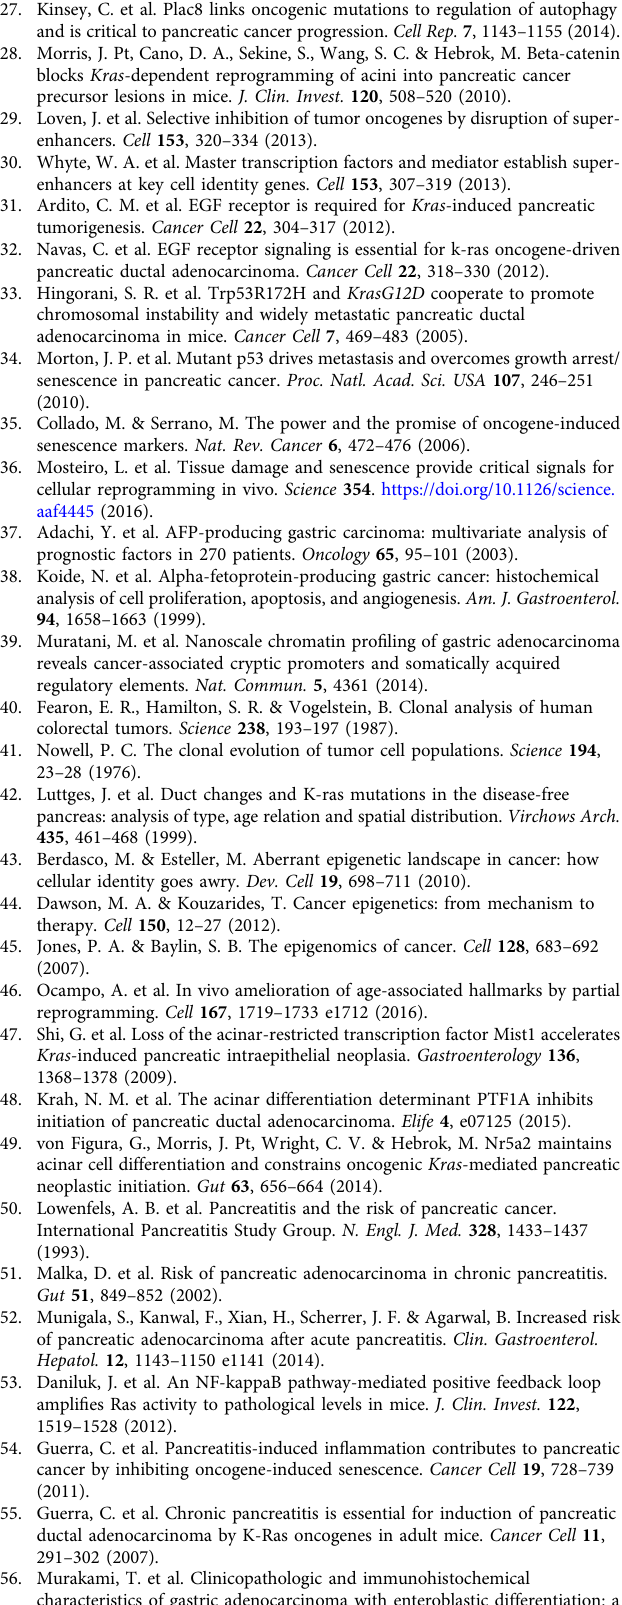
Patients-derived paraf fi n-embedded tissue samples . Human patients-derived paraf fi n-embedded tissue samples were used in compliance with ethical regulations in Kyoto University Hospital. Statistical analysis of survival . Kaplan – Meier survival curves were calculated using the survival time for each mouse. The Log-rank test was used to test for signi fi cant differences between the groups using Prism 7 Software